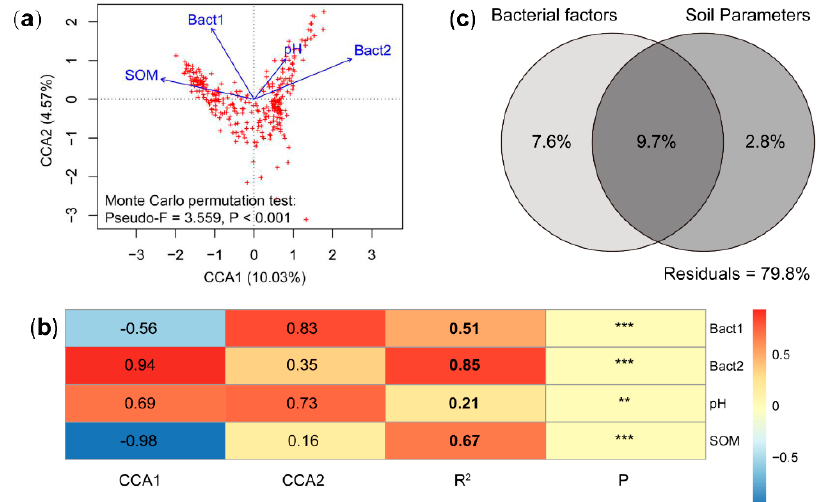
Figure 3. The contribution of soil abiotic and bacterial factors affecting myxobacterial community of subtropical and tropical forest soil. ( a ) CCA of soil myxobacterial community composition constrained by soil bacterial community (Bact1, Bact2) and soil abiotic parameters (pH, SOM); Bact1 and Bact2 indicate first and second principal components generated from PCoA using soil microbial community composition data (the first and second principal components explained 57% of the variation of the 71 soil bacterial communities). ( b ) Correlations between ordination axis and constrained factors and their significance indicated by Monte Carlo permutation test; R 2 means the effect size of specific factor on soil myxobacteria, and p < 0.05 indicates a significant effect on myxobacterial community. ( c ), VPA indicated the effects of soil abiotic and bacterial factors on the myxobacterial community composition; the data present the percentage of variations explained by the factors.